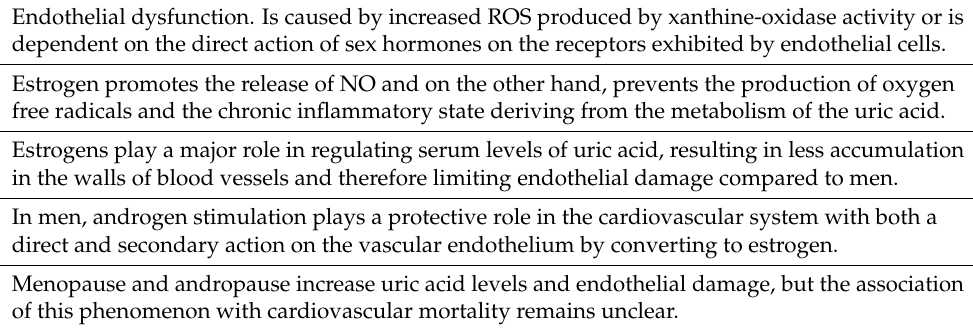
Table 1. Take-home messages. Endothelial dysfunction. Is caused by increased ROS produced by xanthine-oxidase activity or is dependent on the direct action of sex hormones on the receptors exhibited by endothelial cells. Estrogen promotes the release of NO and on the other hand, prevents the production of oxygen free radicals and the chronic inflammatory state deriving from the metabolism of the uric acid. Estrogens play a major role in regulating serum levels of uric acid, resulting in less accumulation in the walls of blood vessels and therefore limiting endothelial damage compared to men. In men, androgen stimulation plays a protective role in the cardiovascular system with both a direct and secondary action on the vascular endothelium by converting to estrogen. Menopause and andropause increase uric acid levels and endothelial damage, but the association of this phenomenon with cardiovascular mortality remains